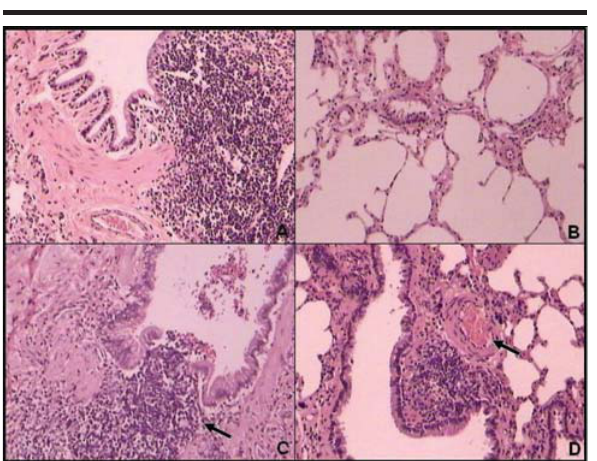
FIGURE 3 - Microscopy of the pulmonary sections of the group 20mg/kg. A) 08 weeks. Lymphoid nodular hyperplasia (BALT). B) 10 weeks. Pulmonary emphysema with focal inflammation areas. C) 12 weeks. Diffuse chronic inflammatory process. The arrow shows lymphoid nodular hyperplasia (BALT). D) 14 weeks. Diffuse chronic inflammatory process, with emphysema areas and thickness of the alveolar walls. Lymphoid nodular hyperplasia (BALT). Congested blood vase (arrow). (HE, 100X)